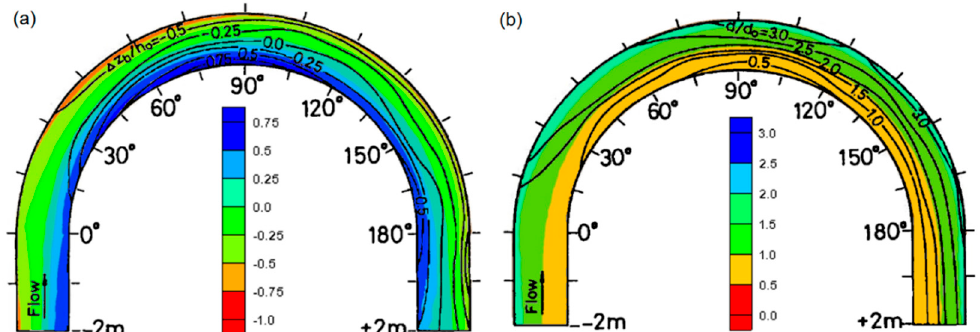
Figure 11. Measured (isolines) and BASEMENT calculated (colored) contours: ( a ) bed evolutions normalized by the initial water depth ( h 0 = 0.0544 m); ( b ) median sediment size normalized by the initial median diameter.